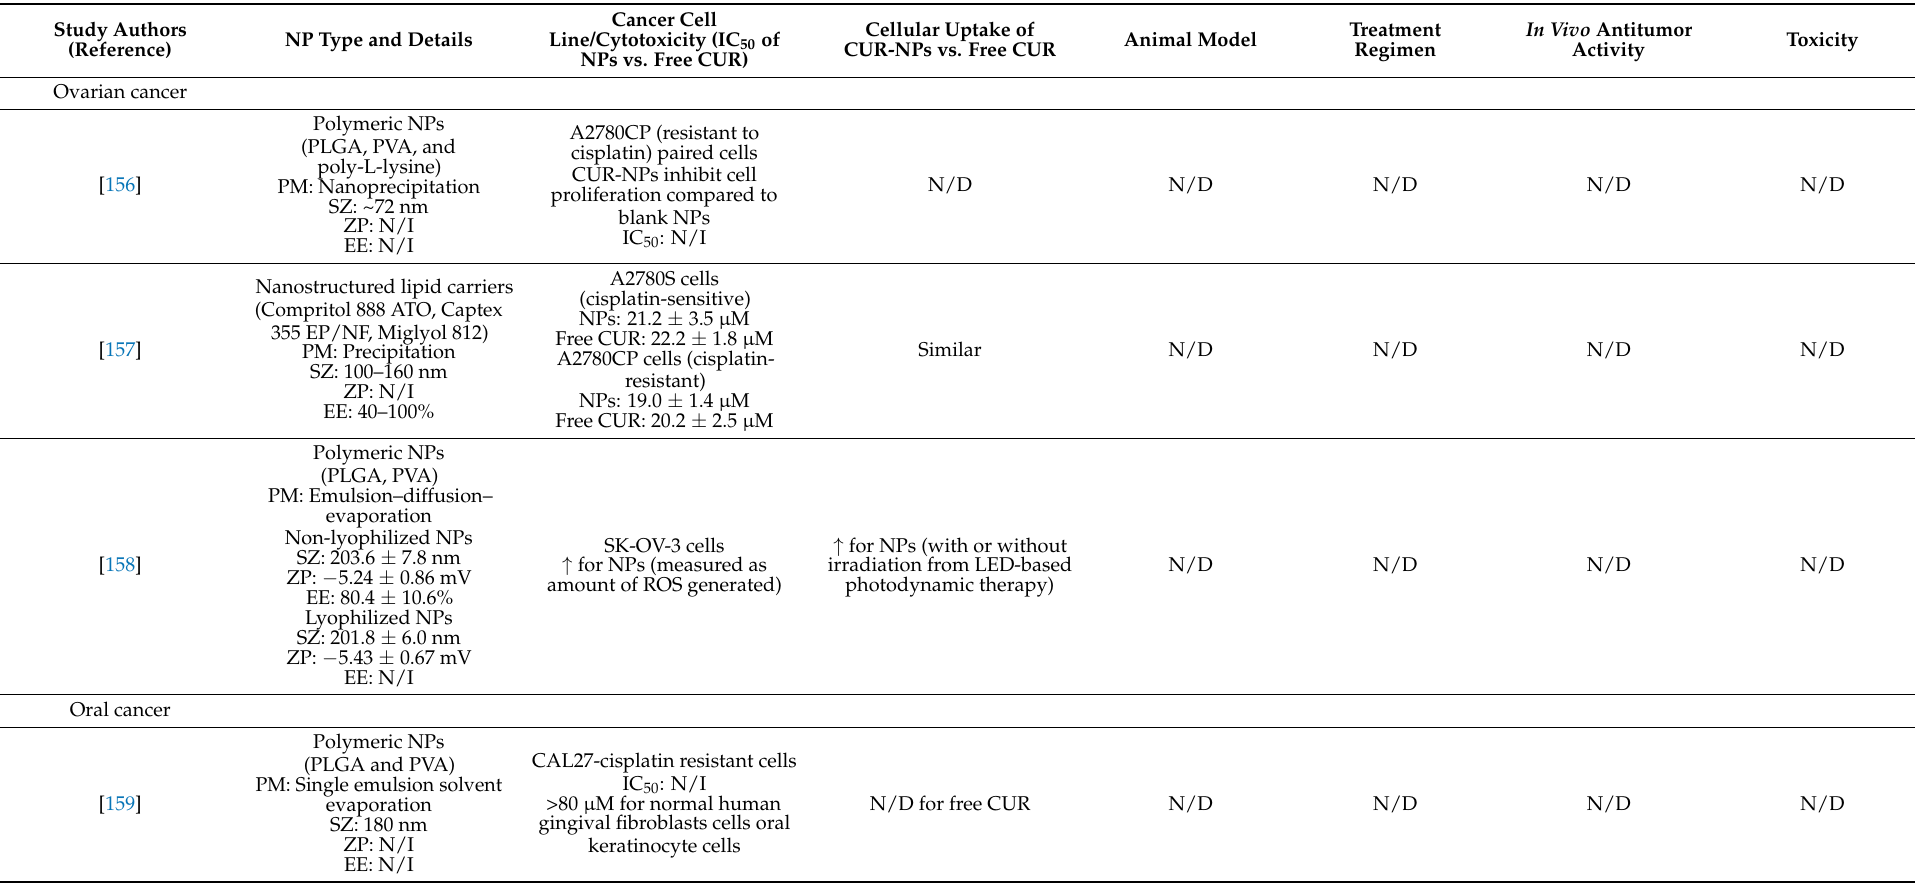
Table 1. Summary of details from studies on CUR nanoformulations for ovarian, oral, cervical, and pancreatic